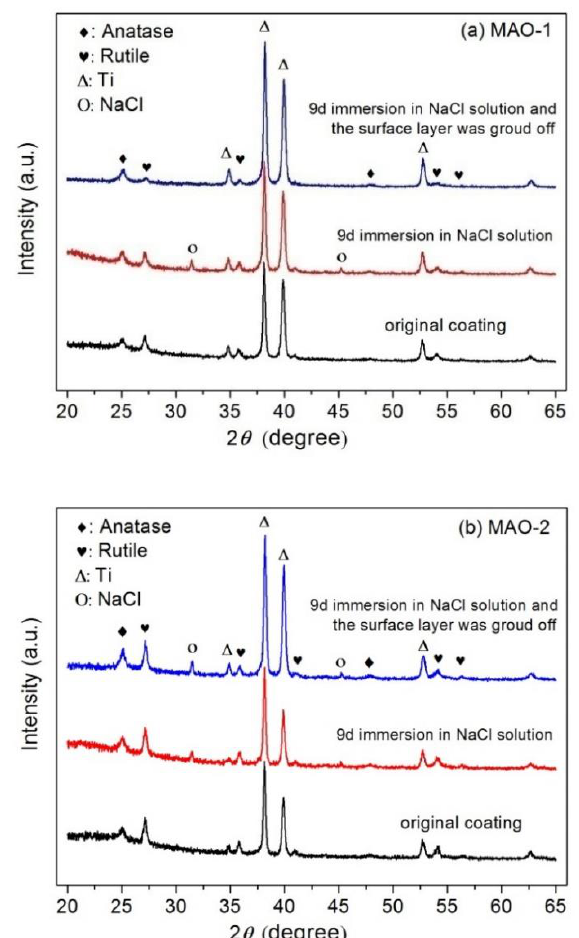
Figure 7. The XRD patterns of the MAO coatings and the MAO coatings after 9 days immersion in 3.5% NaCl solution: ( a ) MAO-1 and ( b ) MAO-2 coating.